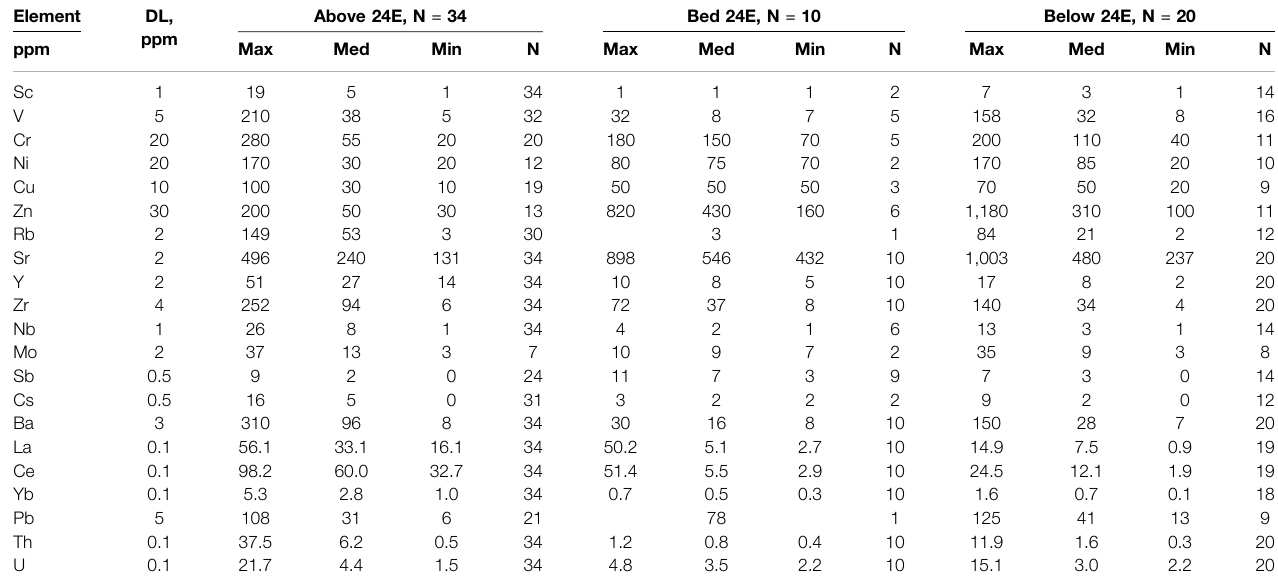
TABLE 3 | Summary of whole rock trace element data. Element